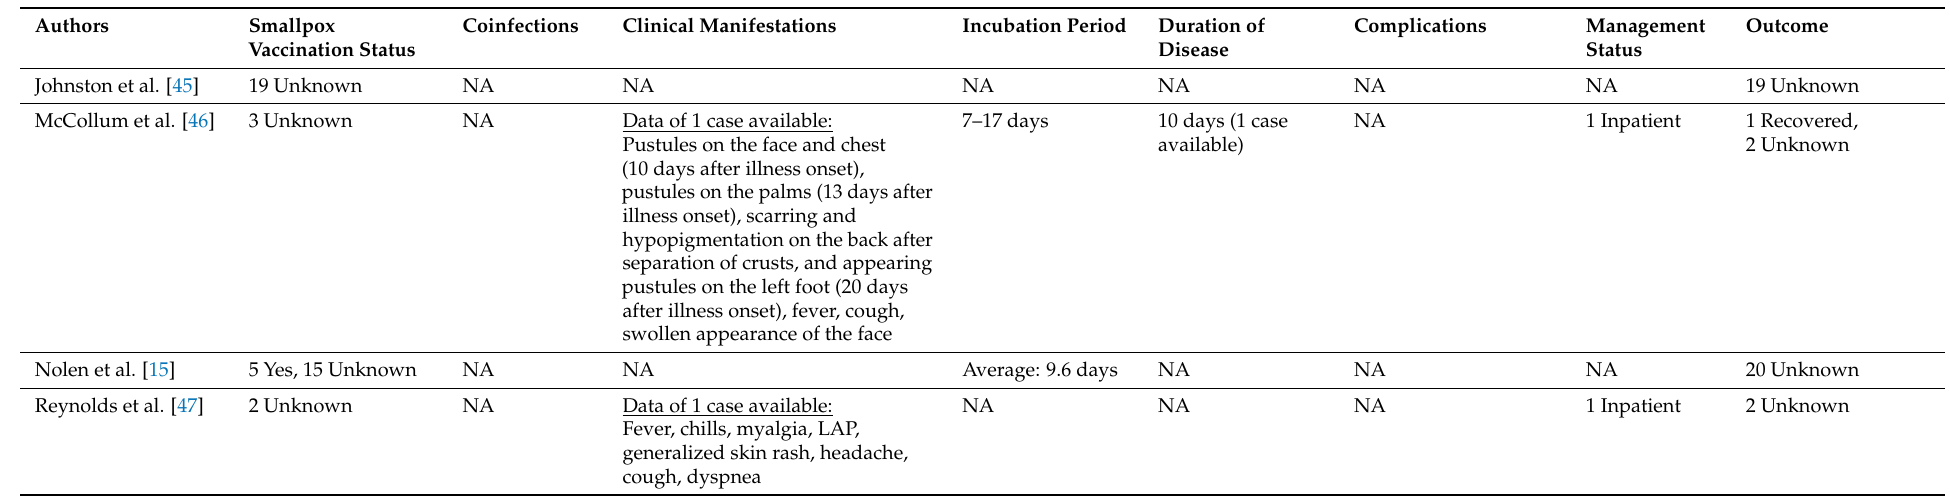
Table 5. Clinical characteristics of the study population (confirmed